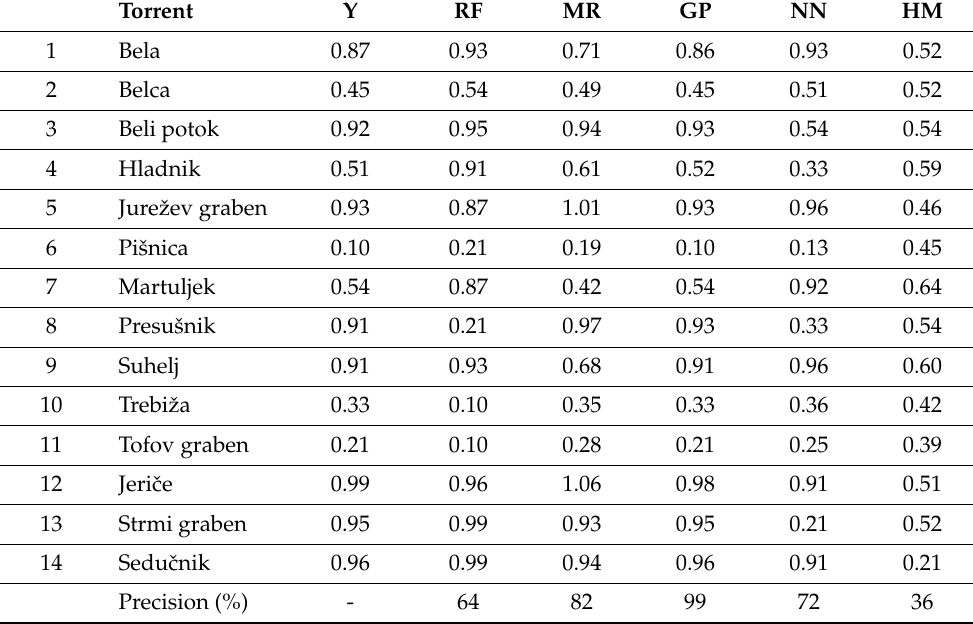
Table 4. Experimental (Y) and prediction